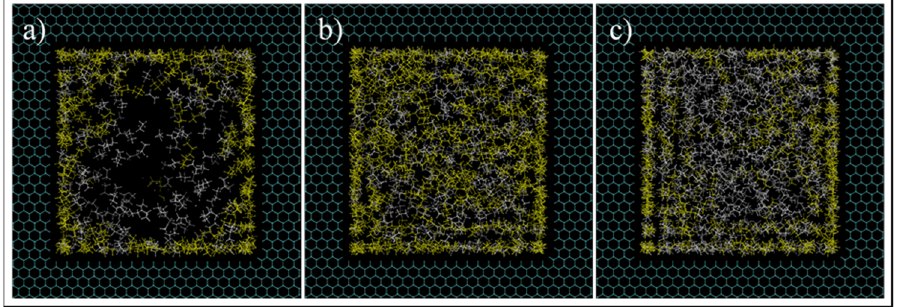
Figure 14. Images at the pore entrance of C1 ( a ), C2 ( b ), and C3 ( c ) conditions simulations. Yellow and white colors are heptane and ethane molecules, respectively.